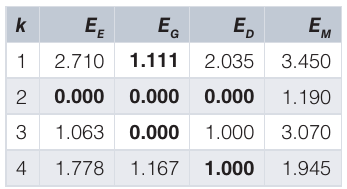
Table 1. Average cluster numbers over n = 200 runs.